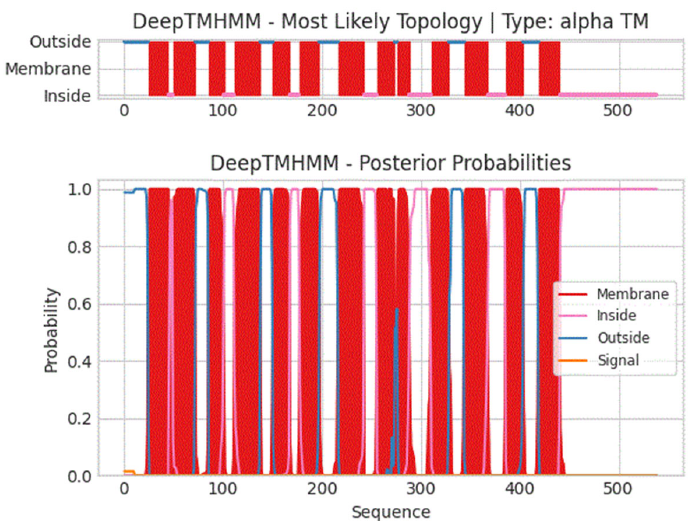
Figure 4. Structural analysis of HbNHX1 protein.The topological structure of the HbNHX1 protein was analyzed using TMHMM software (https://dtu.biolib.com/DeepTMHMM, accessed on 3 March 2020). The hydrophobic sequence with 13 transmembrane regions is shown in the large rectangle.